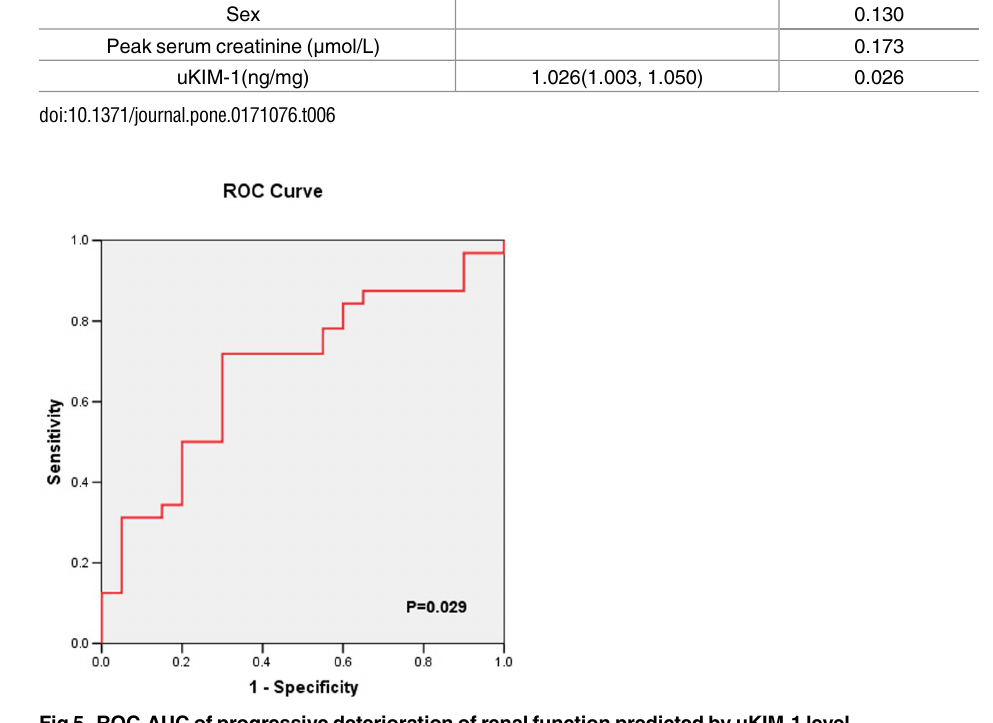
Fig 5. ROC-AUC of progressive deterioration of renal function predicted by uKIM-1 level.